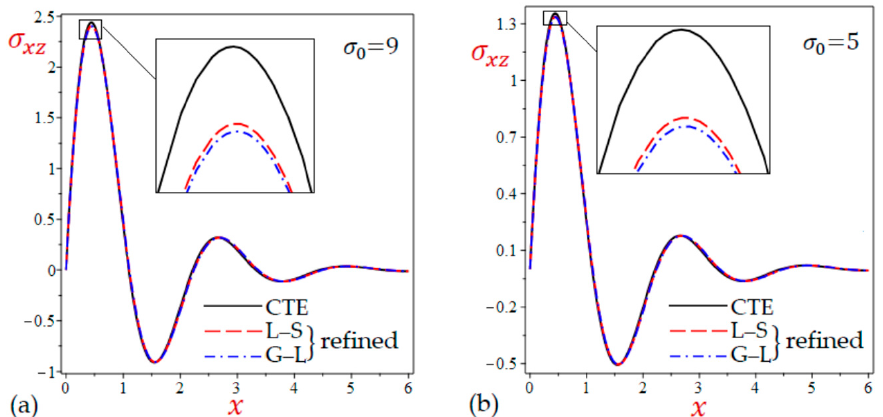
without initial pressure ( 𝓅 = 0 ) ( a ) 𝜎 (cid:2868) = 9 ; ( b ) 𝜎 (cid:2868) = 5 .